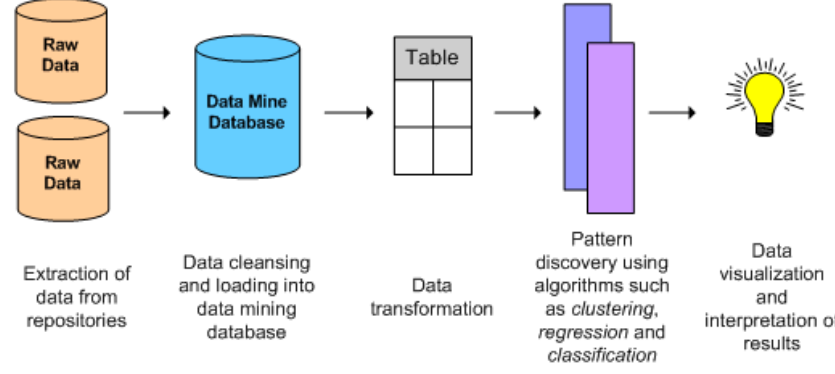
Figure 4. Schematic of the data mining